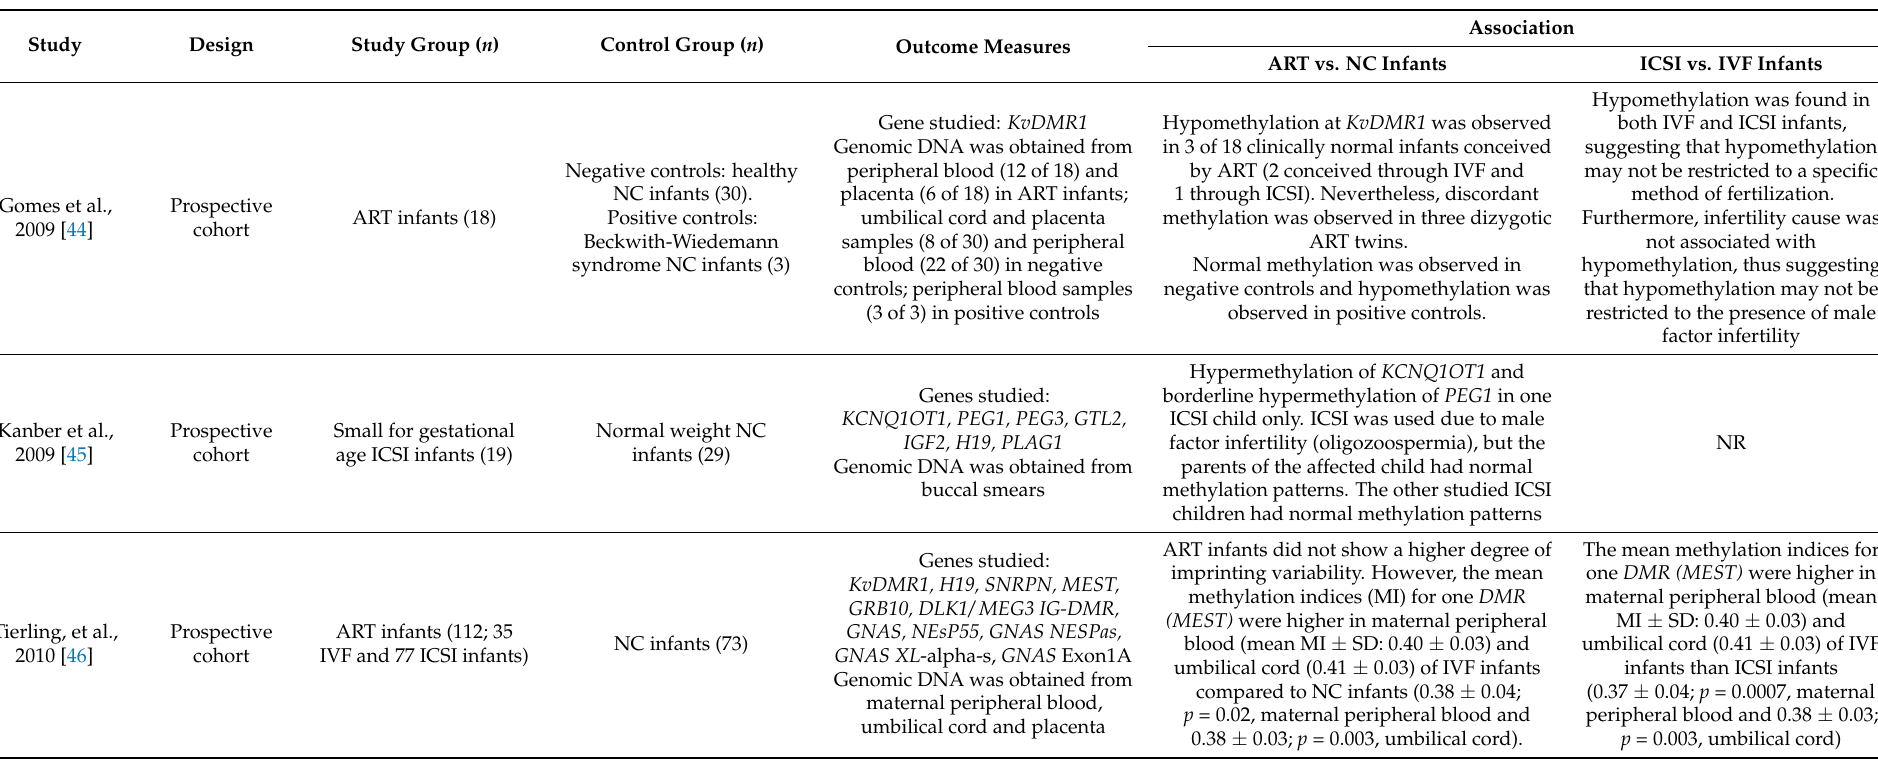
Table 1. Studies comparing DNA methylation and imprinting/epigenetic diseases in ART infants and natural conceived infants. AGA, appropriate for gestational age; ART, assisted reproductive technology; DMRs, differentially methylated region; DNA, deoxyribonucleic acid; ICSI, intracytoplasmic sperm injection; IVF, conventional in vitro fertilization; MI, methylation indices; NC, naturally conceived; NR, not reported; OI, ovulation induction; RNA, ribonucleic acid; SD, standard deviation; SGA, small for gestational age. Adapted with permission from Ref